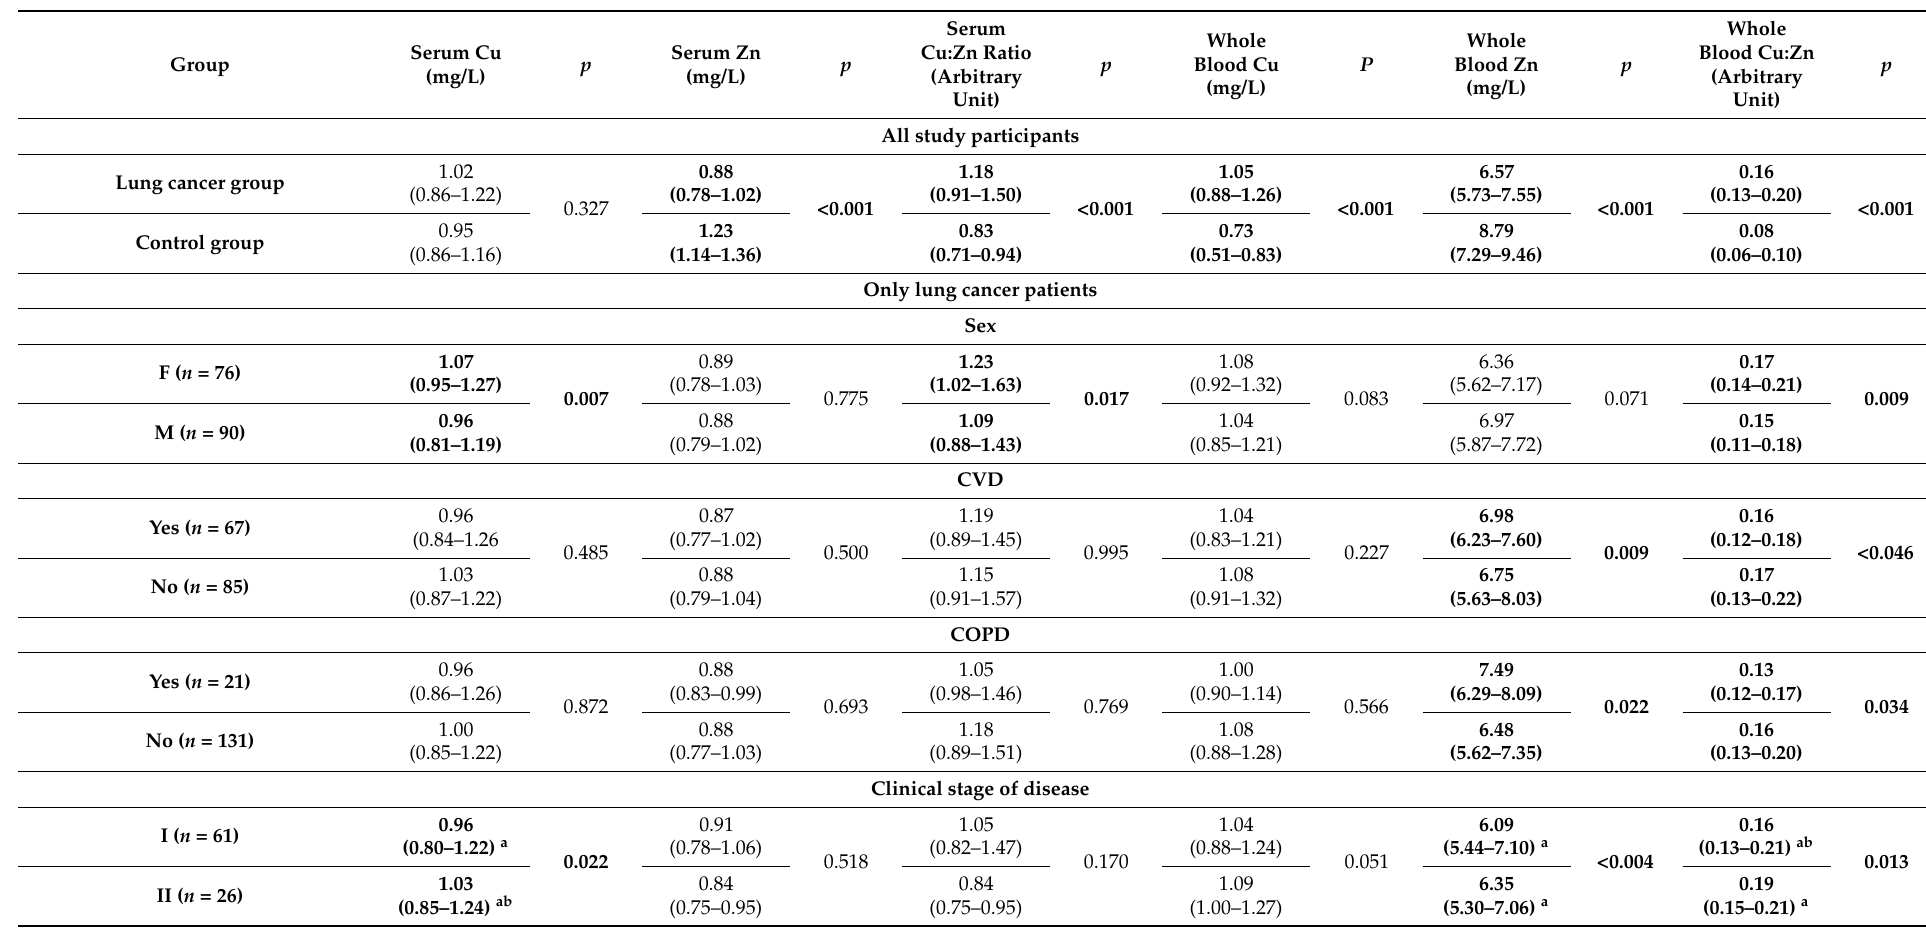
Table 2. Median serum and whole blood Cu and Zn concentrations and Cu:Zn ratio in control group and lung cancer patients and in lung cancer subgroups according to different factors, presented as median